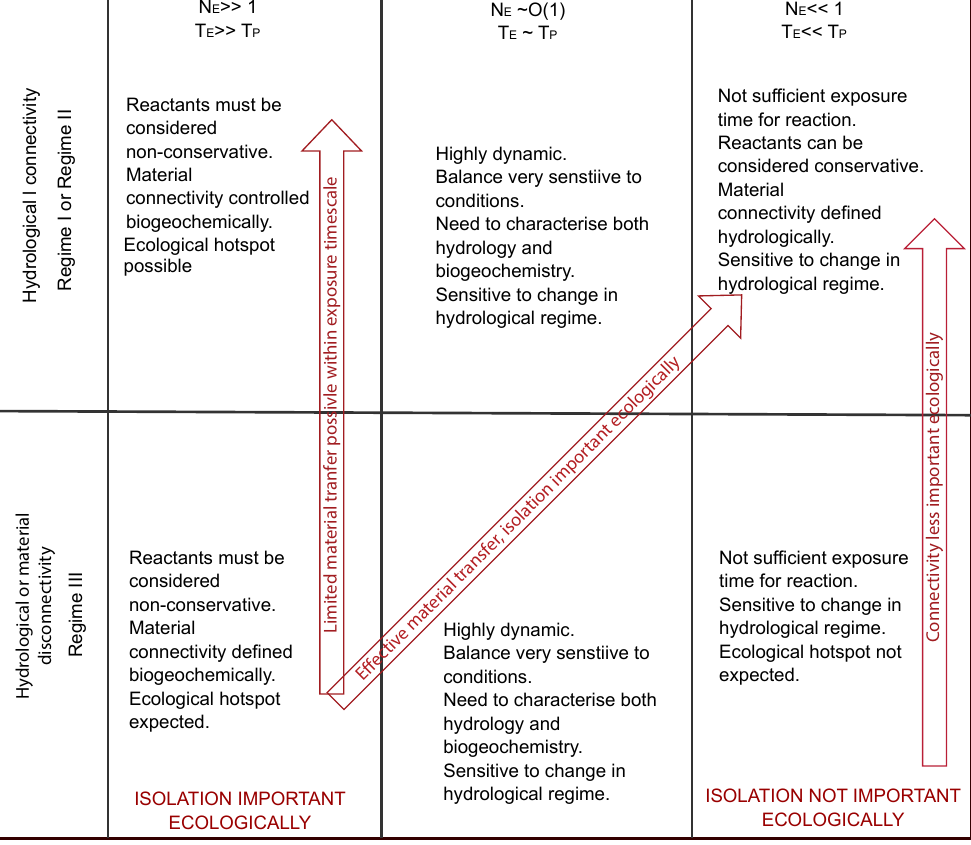
connected after a period of isolation, it is possible for them to rapidly move across regimes. The balance between exposure timescales (both